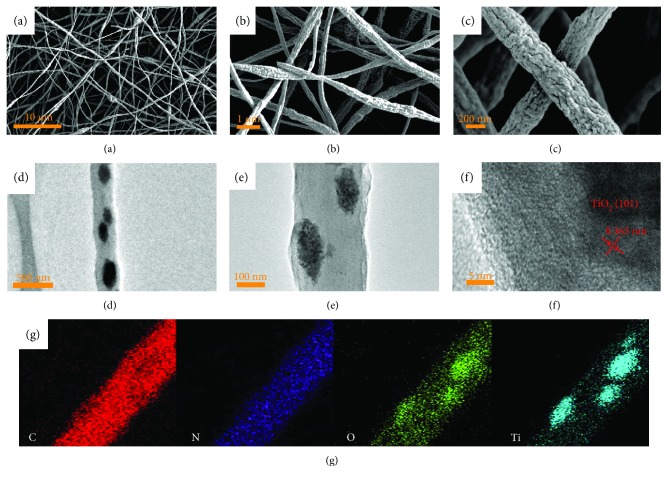
SEM images (a–c), TEM images (d–f), and EDS mapping (g) of CNF-TiO2.